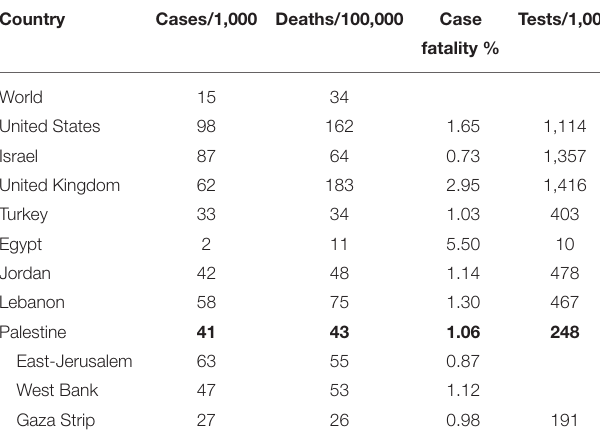
TABLE 2 | Summary of the variation of risk factors for COVID-19 for the three territories.